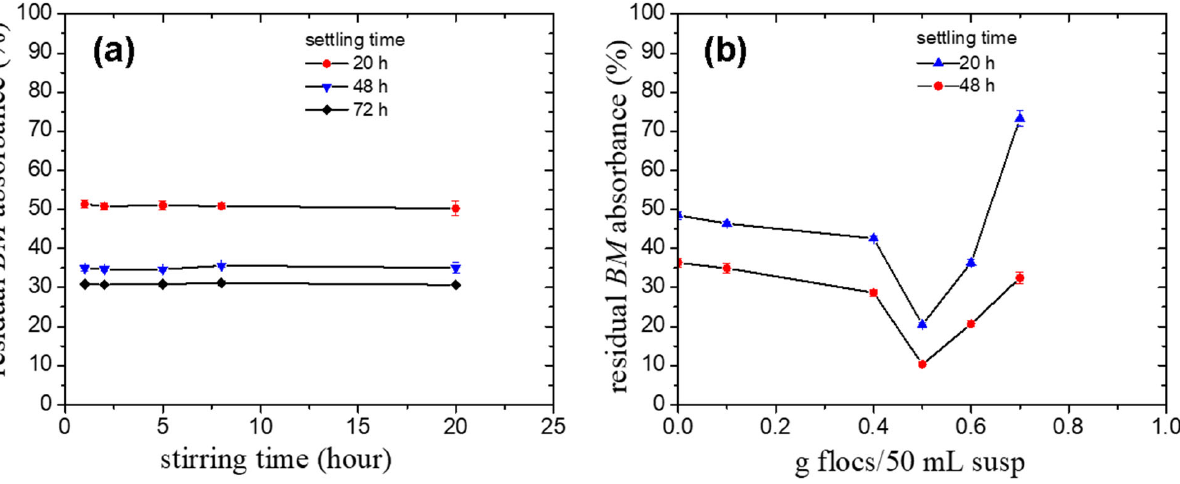
Figure 10. Residual BM absorbance (%) dependence on the stirring time (flocs dose: 0.1 g flocs/50 mL suspension) ( a ) and the flocs dose ( b ) (stirring time 1 h).